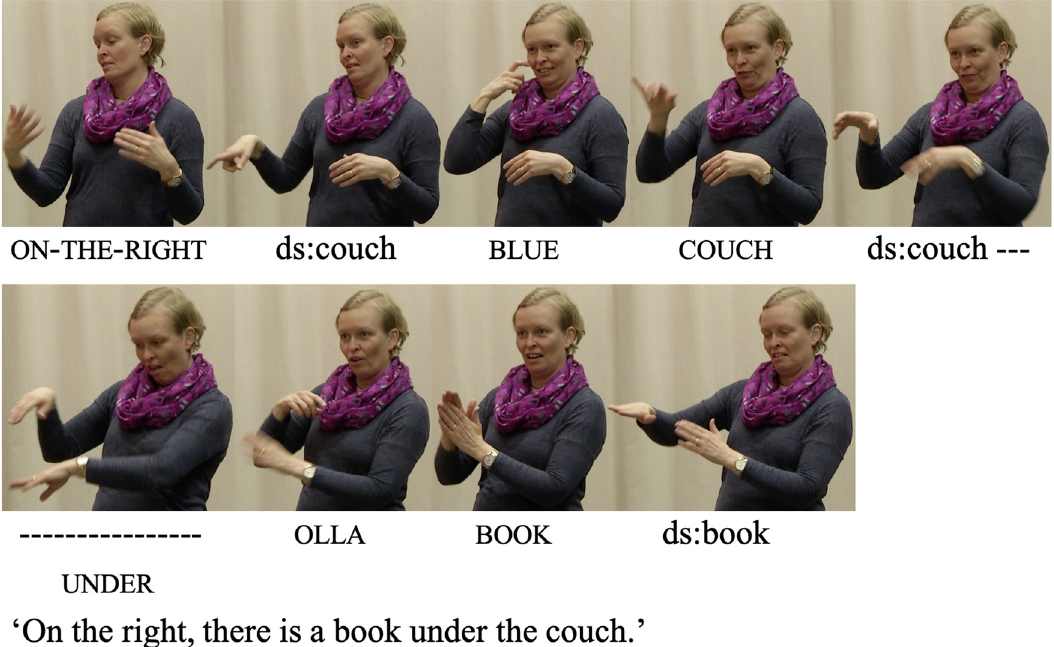
Figure 8: An example of the simultaneous production of Ground on H1 and an adposition sign on